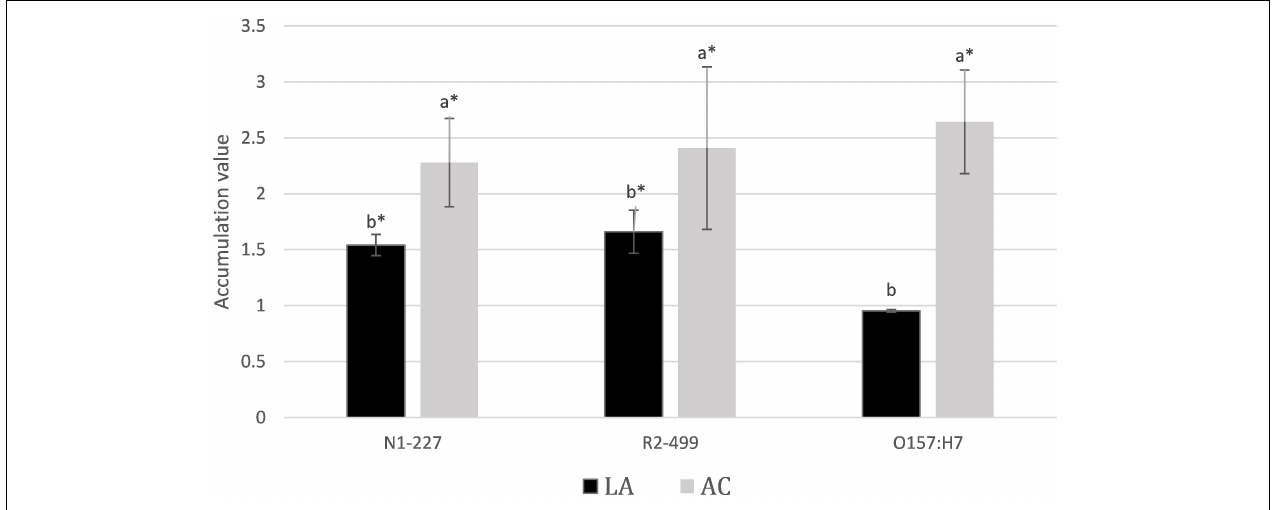
FIGURE 1 | Average relative acid anion accumulation after 1 h. Relative acid anion accumulation into pellets of Listeria monocytogenes N1-227, L. monocytogenes R2-499, and Escherichia coli O157:H7 following 1 h in habituation media. Values represent treatment means and include bars of the standard error. Treatment details: LA, lactic acid treatment (TSB adjusted to pH 6.0 with HCl containing 4.75 mM lactic acid); AC, acetic acid treatment (TSB adjusted to pH 6.0 with HCl containing 4.75 mM acetic acid). Superscripts identify significant differences within strains ( p < 0.05). Asterisk signifies that accumulation was significantly greater than 1 (CI <